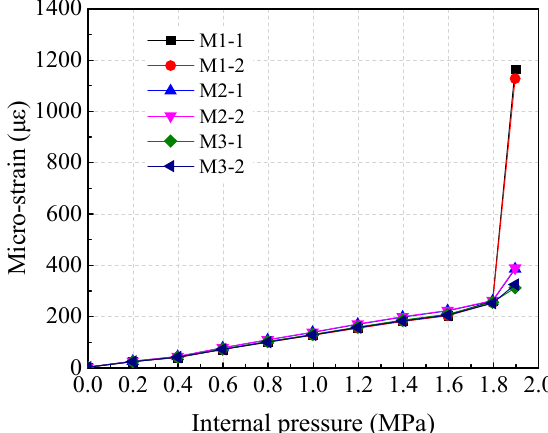
Figure 11. Changes of mortar strain with internal water pressure.